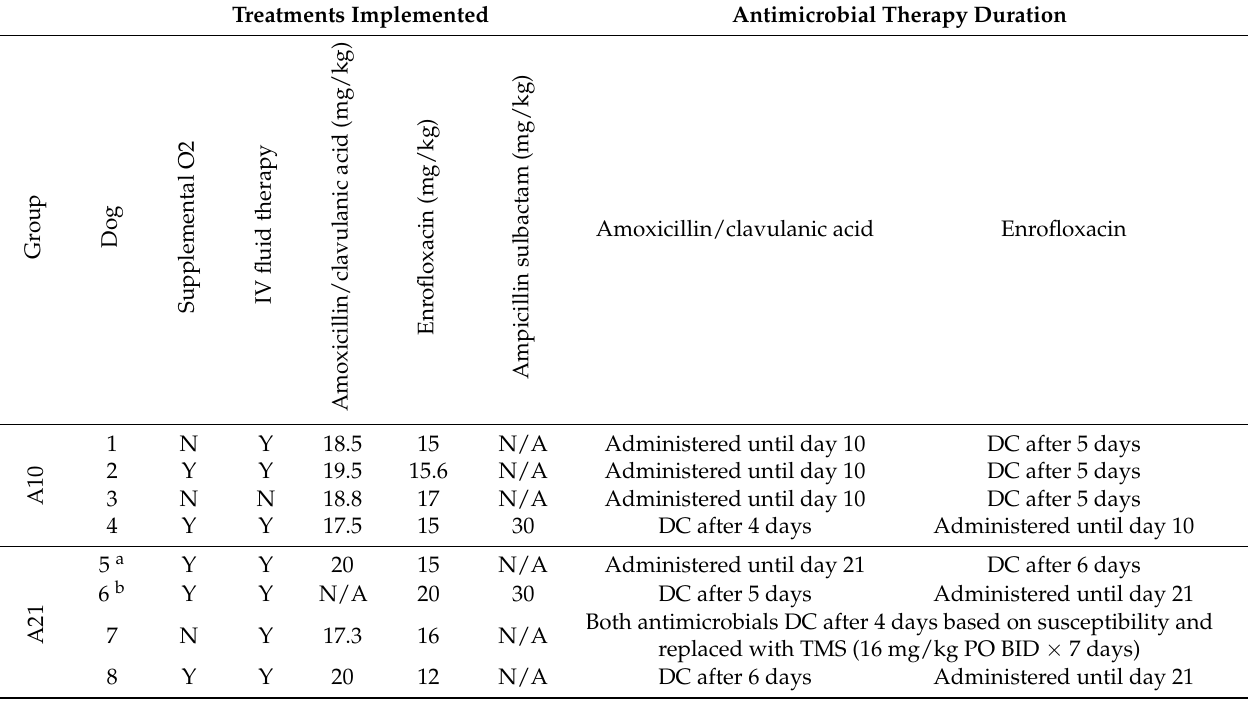
At the time of the third visit, owners reported that the cough character had changed back to an intermittent dry cough. This patient was later diagnosed with laryngeal paralysis. Table 3. Summary of treatments implemented while hospitalized and after discharge for all patients. Treatments Implemented